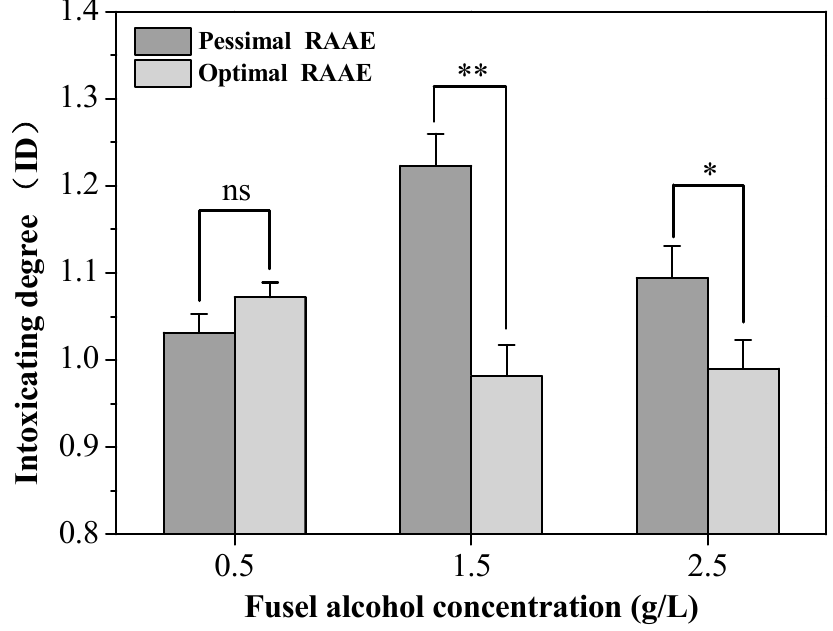
Figure 1. The effects of fusel alcohol concentration on the intoxicating degree (ID) of formulated liquors (FLs). Each value is expressed as the mean ± standard deviation ( n = 3). Levels of statistical significance are compared among FLs with same fusel alcohol concentrations (ns: not significant; * p < 0.05; ** p < 0.01; RAAE: the ratio of alcohols/acids/esters).